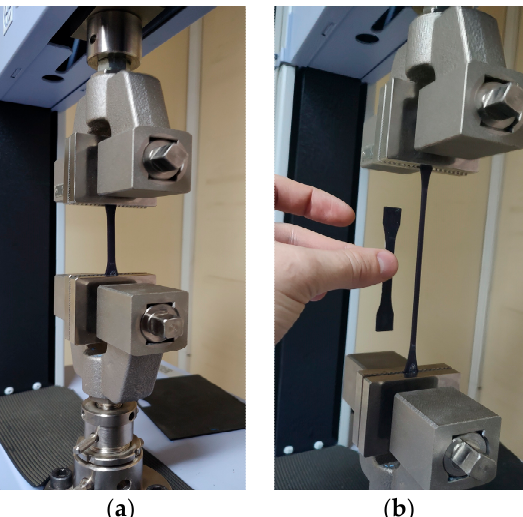
Figure 10. The setup for tensile testing: ( a ) unloaded test tube and ( b ) loaded test tube. As a result of the tensile test for the 3D-printed Taulman Nylon 230 material, the stress– strain curve shown in Figure 11 was obtained. The orange line illustrates the hypothetical straight line that the material would follow if it were constantly in the area of elasticity (in the region where Hook’s law applies), whereas the blue line depicts the actual behavior of this material when it is stretched. The slope of the straight-line portion of the stress– strain curve can be utilized to define the modulus of elasticity (Young’s modulus). Special attention should be paid to the instant of the stress point where the material enters the non-linear deformation region (i.e., when the blue and the orange lines diverge), as this is the region where the compliant fingers material is when the large angular deformations take